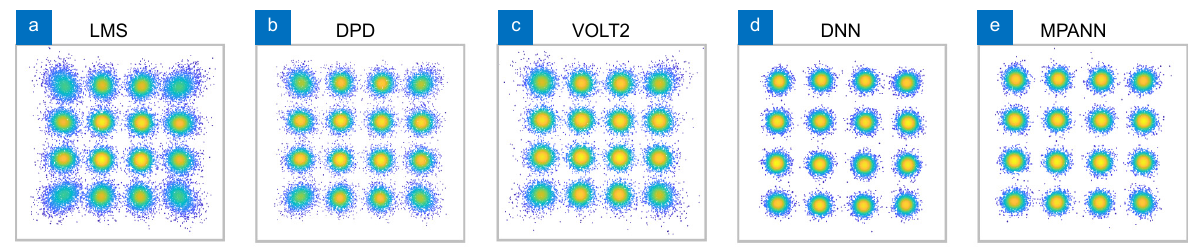
Fig. 8 | The constellation diagram of CAP-16-QAM at 2.4 Gbit/s using the setup in Fig.3 when the first-stage equalization scheme is LMS, DPD, VOLT2, DNN and MPANN,